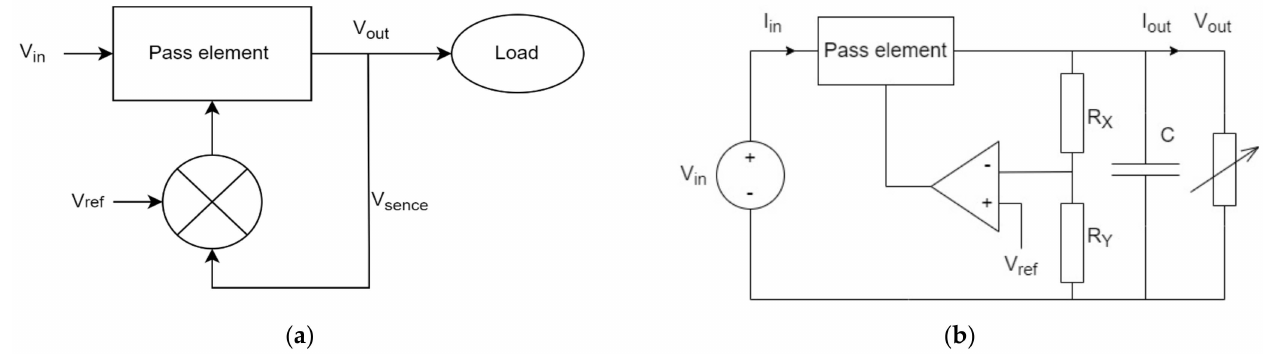
Figure 4. ( a ) Linear regulator functional diagram; ( b ) basic linear regulator